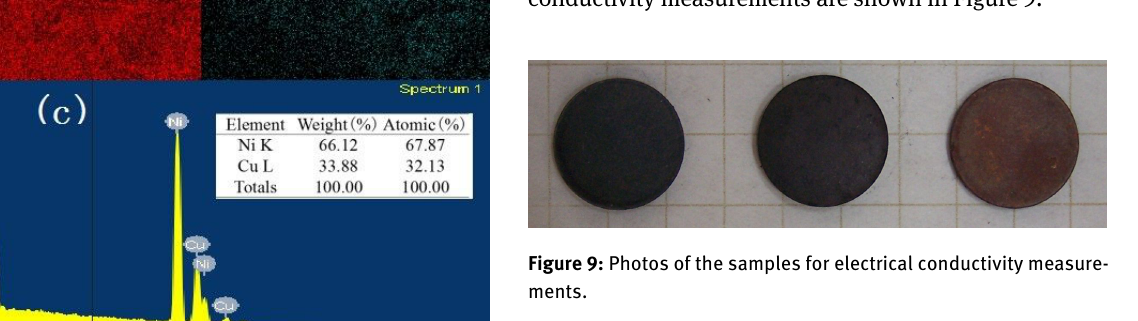
they were used and the conductivity were compared. Then post-treated powders were pressed into coin shape under the pressure of 100 kg. Photos of the samples for electrical conductivity measurements are shown in Figure 9.